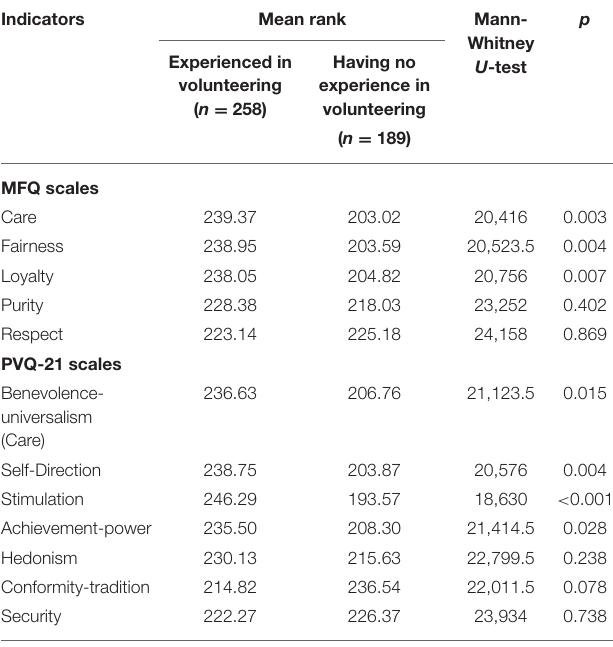
TABLE 4 | Predictors of Russians’ prosocial orientation during the COVID-19 pandemic.